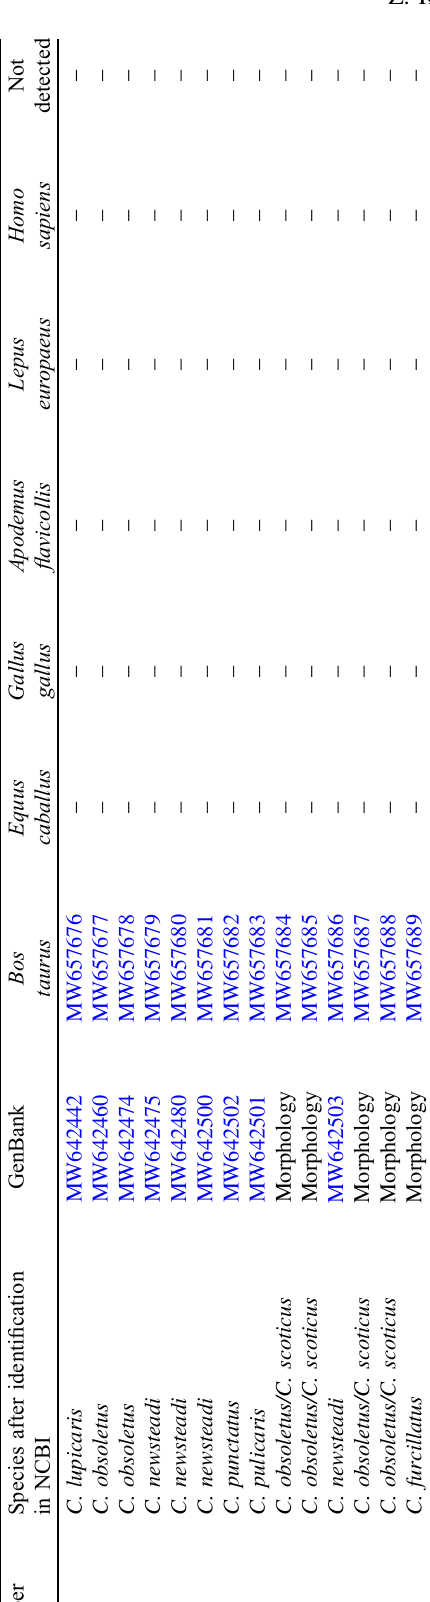
ing step at 95 (cid:3) C for 5 s, 5 cycles (94 (cid:3) C, 40 s; 45 (cid:3) C, 40 s; 72 (cid:3) C, 60 s), followed by 45 cycles (94 (cid:3) C, 40 s; 50 (cid:3) C,